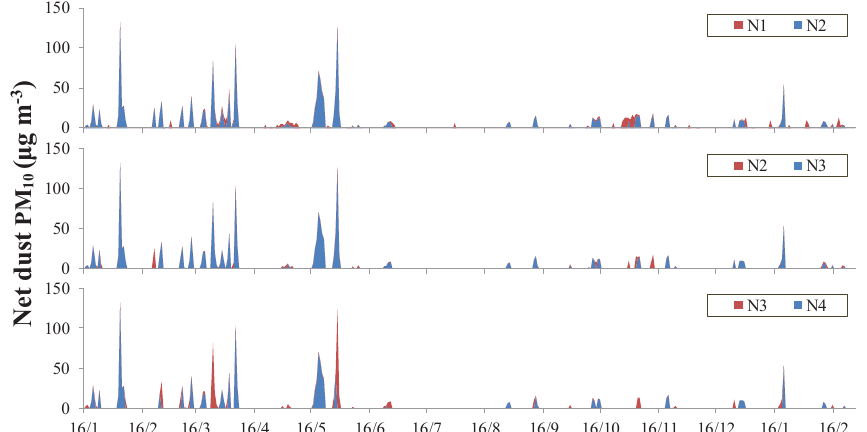
Figure 5. Net dust concentrations calculated from regional PM 10 concentration data: the net dust concentrations when scenarios N2, N3 or N4 are followed are shown in blue. The increment in net dust concentration when a less strict criterion is selected, thus scenarios N1, N2 or N3 are followed, is shown in